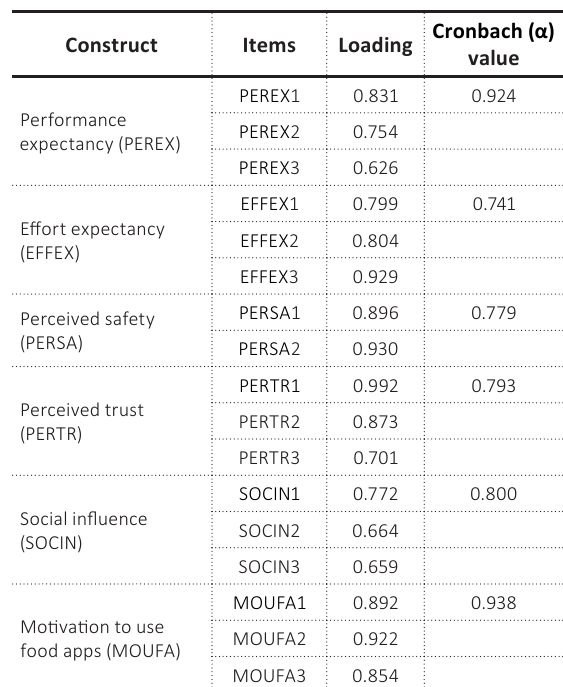
Table 1. Reliability and validity